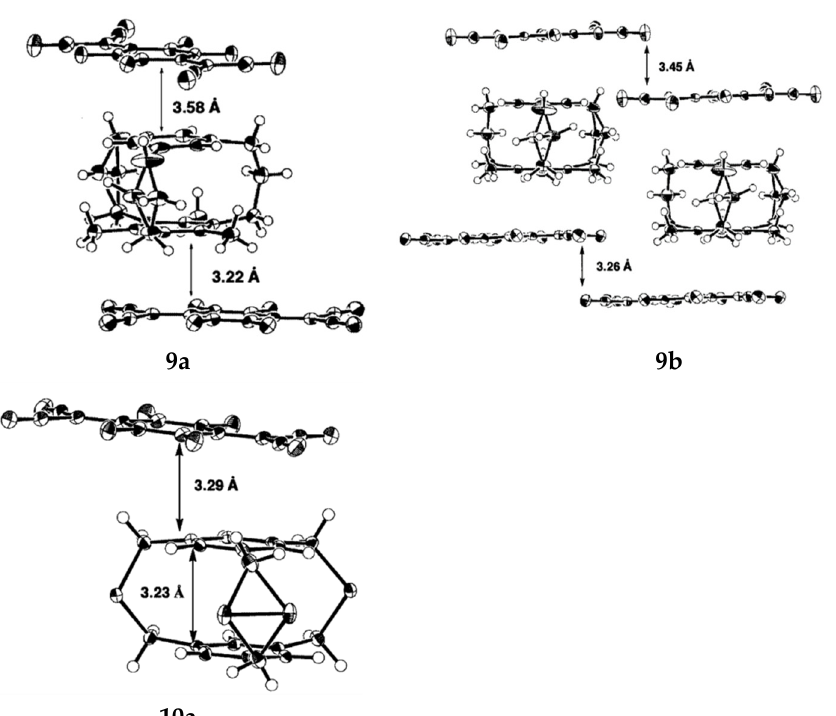
Figure 7. ORTEP drawings of complexes 9 and 10 at − 170 °C (the probability of thermal ellipsoid is 50%).